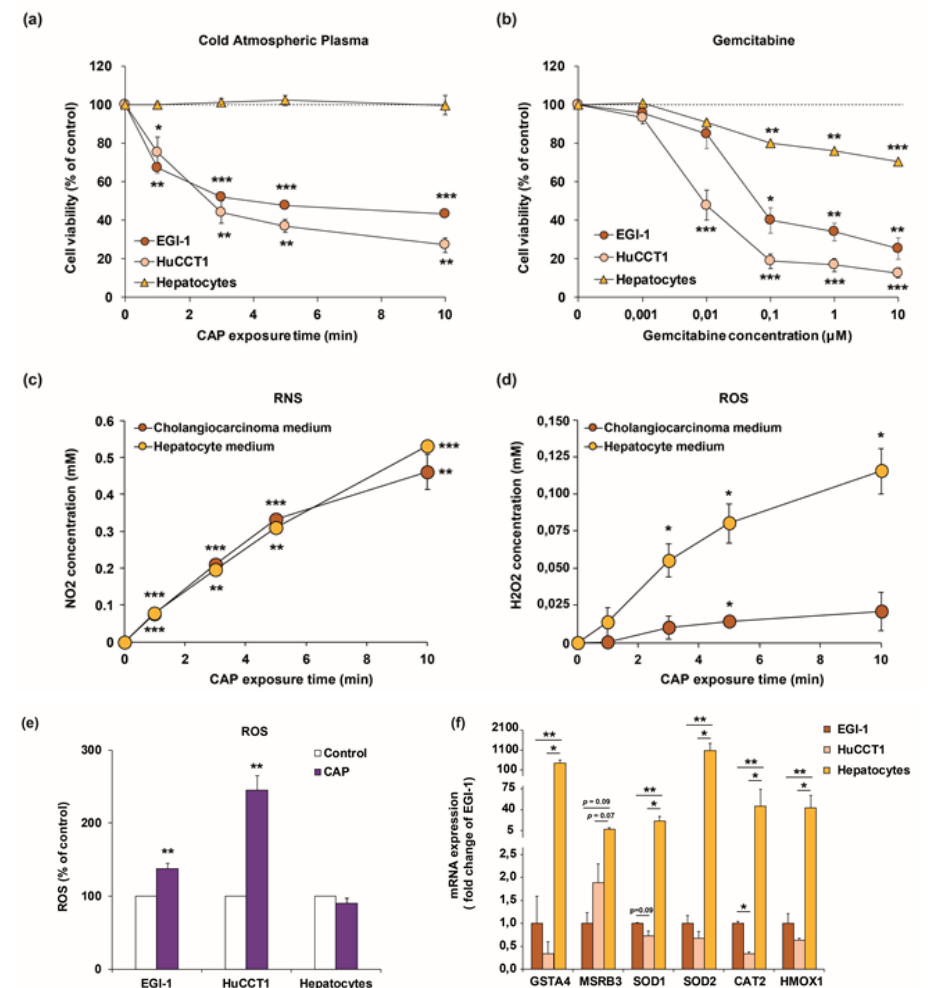
Figure 4. ( a , b ) E ff ect of CAP ( a ) and gemcitabine ( b ) on the viability of EGI-1 and HuCCT1